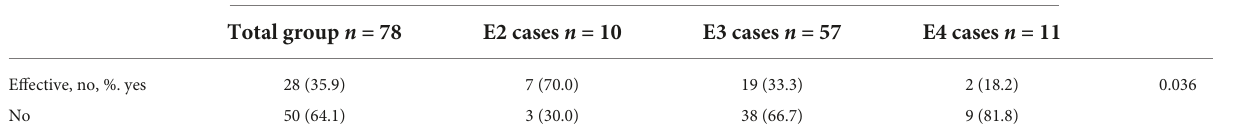
TABLE 7 Changes in vulnerable plaques after 12 months of atorvastatin